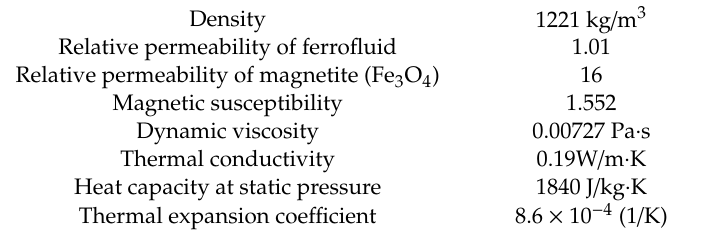
Figure 3. Grid dependency test. Table 1. Physical properties of the ferrofluid